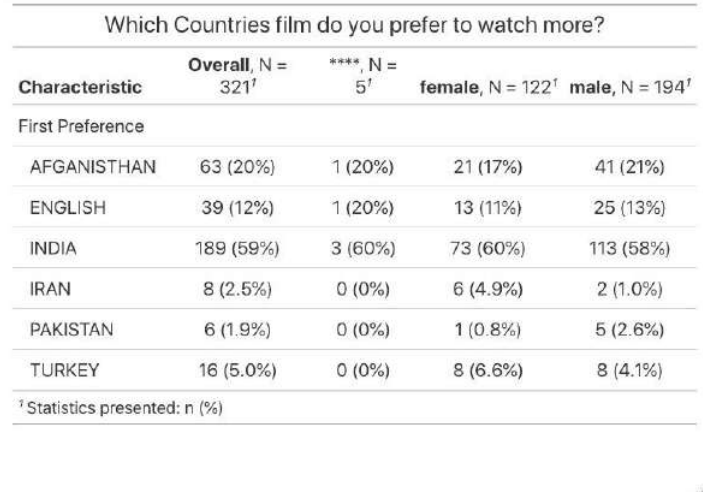
Table 12: Films from which of the following countries do you prefer to watch more? ( Source: Authors‟ depiction